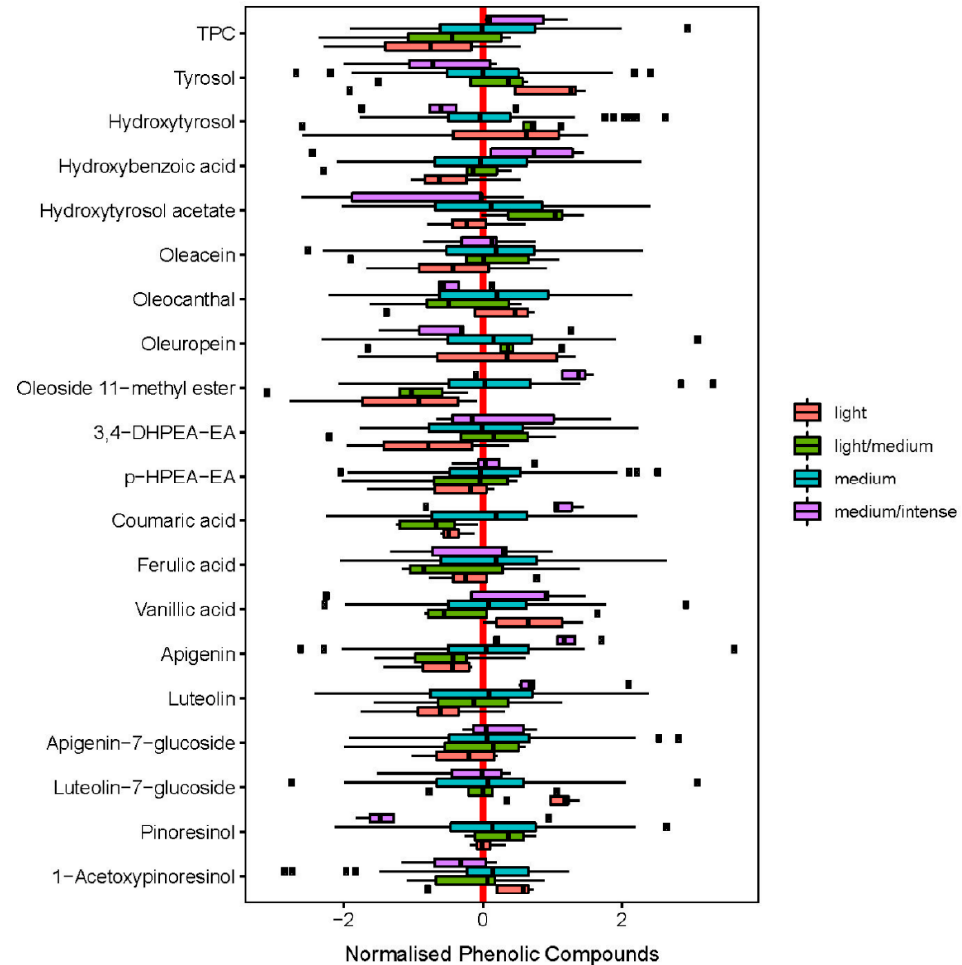
Figure 3. Distribution of individual phenolic compounds between the four different sensory intensity stages light, light/medium, medium and medium/intense in an ascending order.